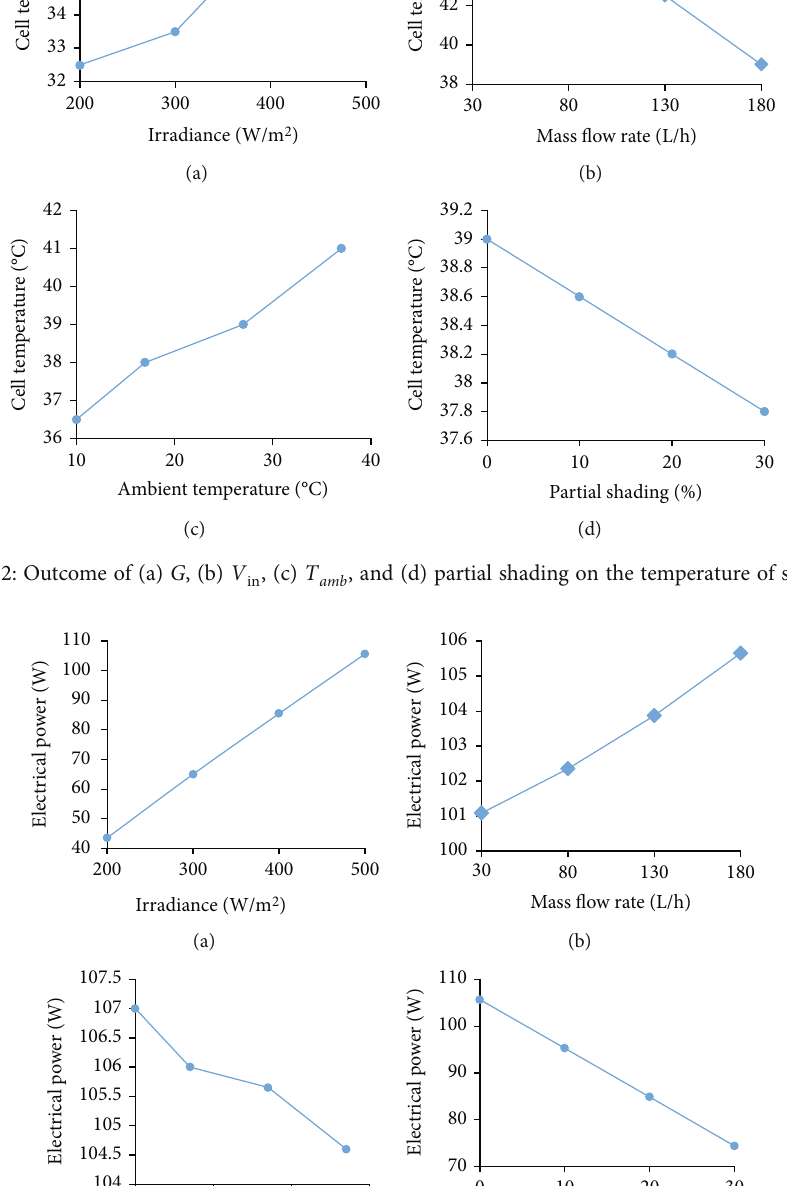
, (c) T , and (d) partial shading on PVT electrical in amb